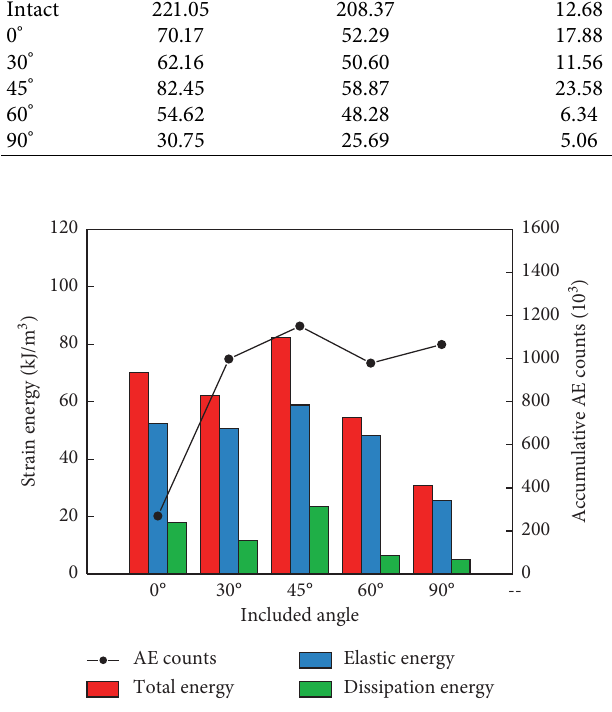
Figure 18: Comparison of peak energy and accumulative AE